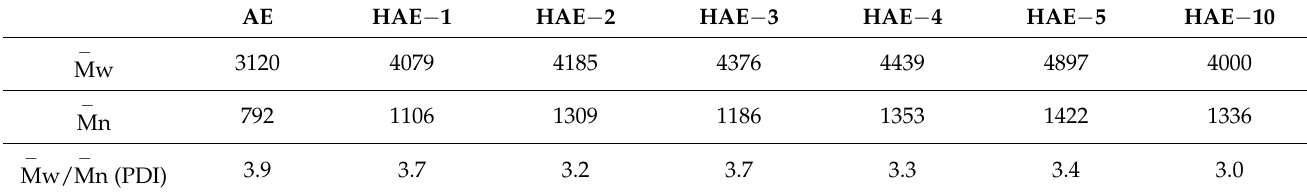
− − Table 3. Mw, Mn, and polydispersity of Ac-AE and Ac-HAEs.